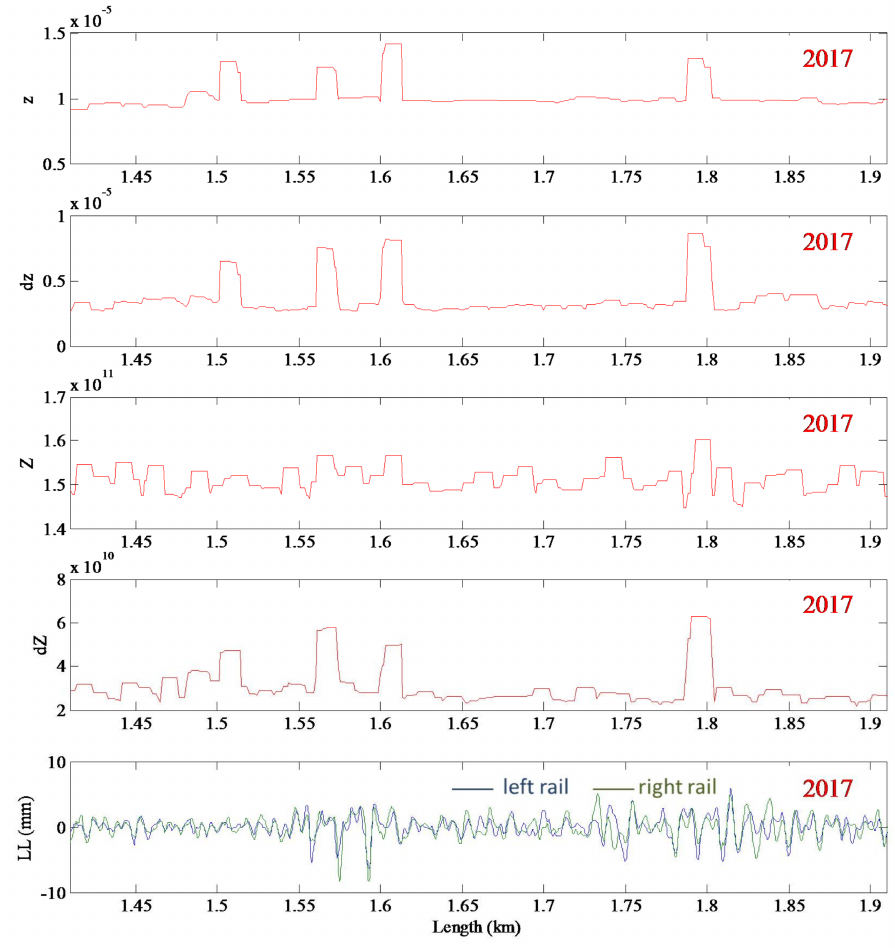
Figure 16. GPR parameters z , dz , Z and dZ and the Longitudinal Level (LL) of the left (blue) and right (green) rails, from the survey in the summer of